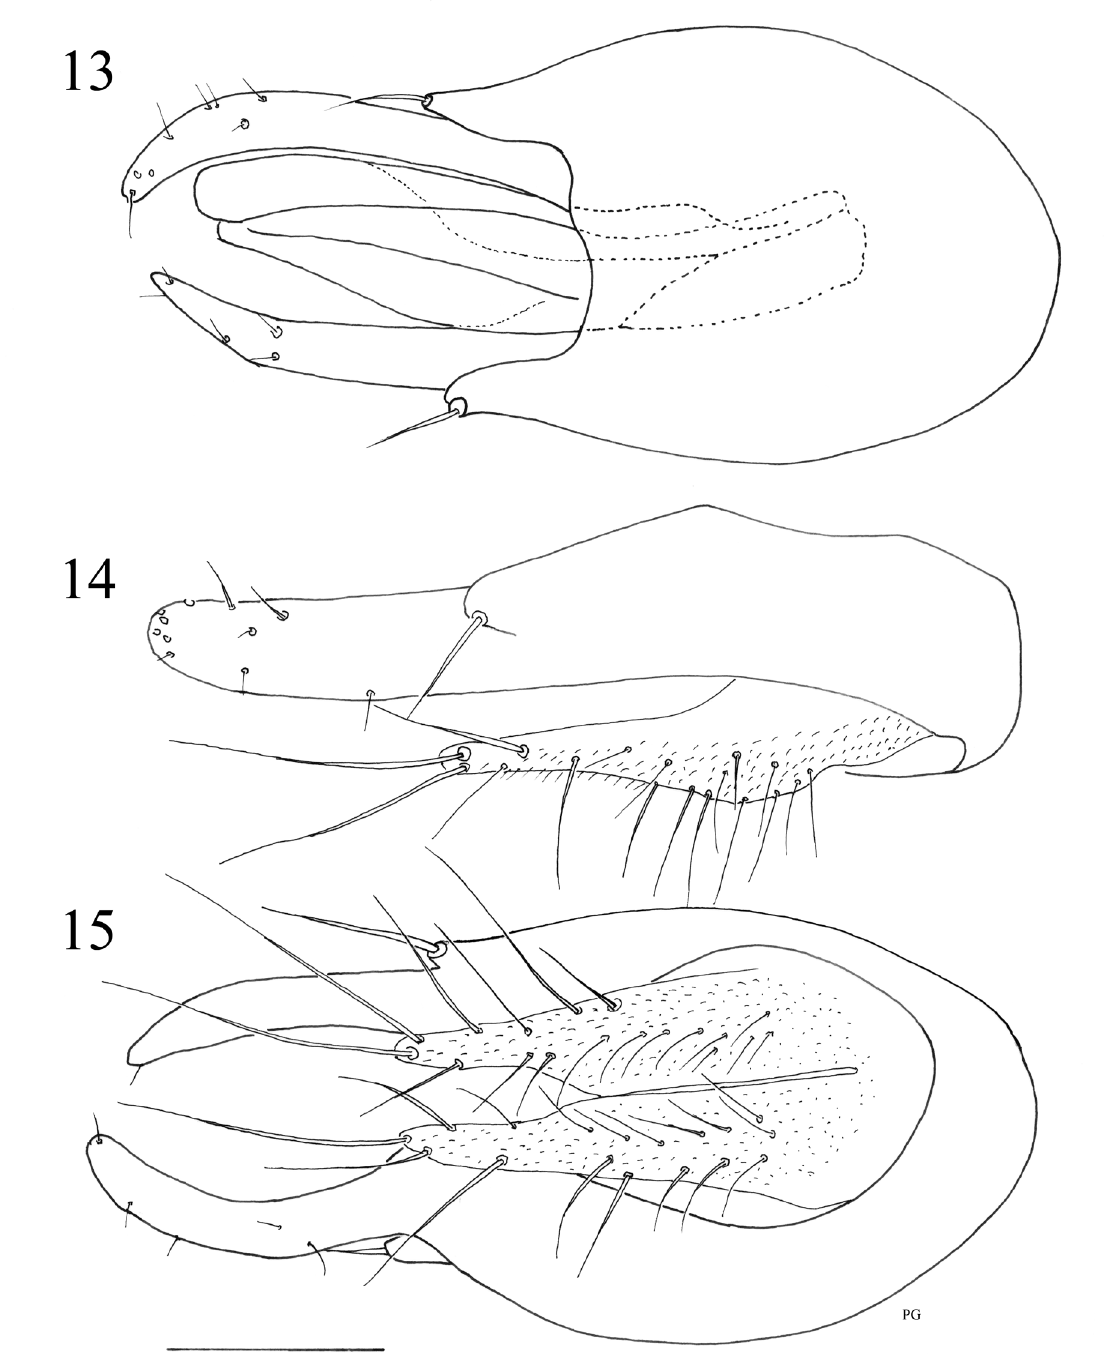
Figs 13–15. Thinophilus minutus sp. nov., ♂, terminalia. 13 . Genital capsule, ventral view. 14 . Genital capsule, lateral view. 15 . Genital capsule, dorsal